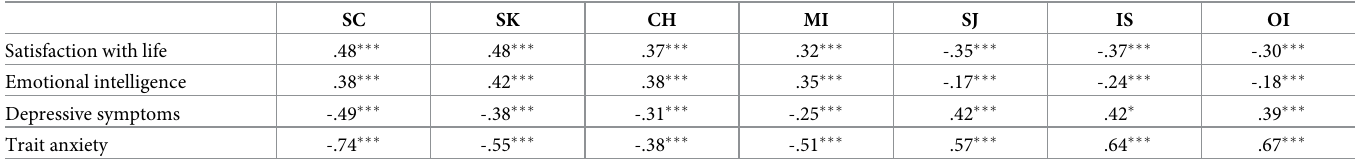
Table 8. Correlations between the SCS, satisfaction with life (SWLS), emotional intelligence (INTE), depressive symptoms (BDI), and trait anxiety (STAI).